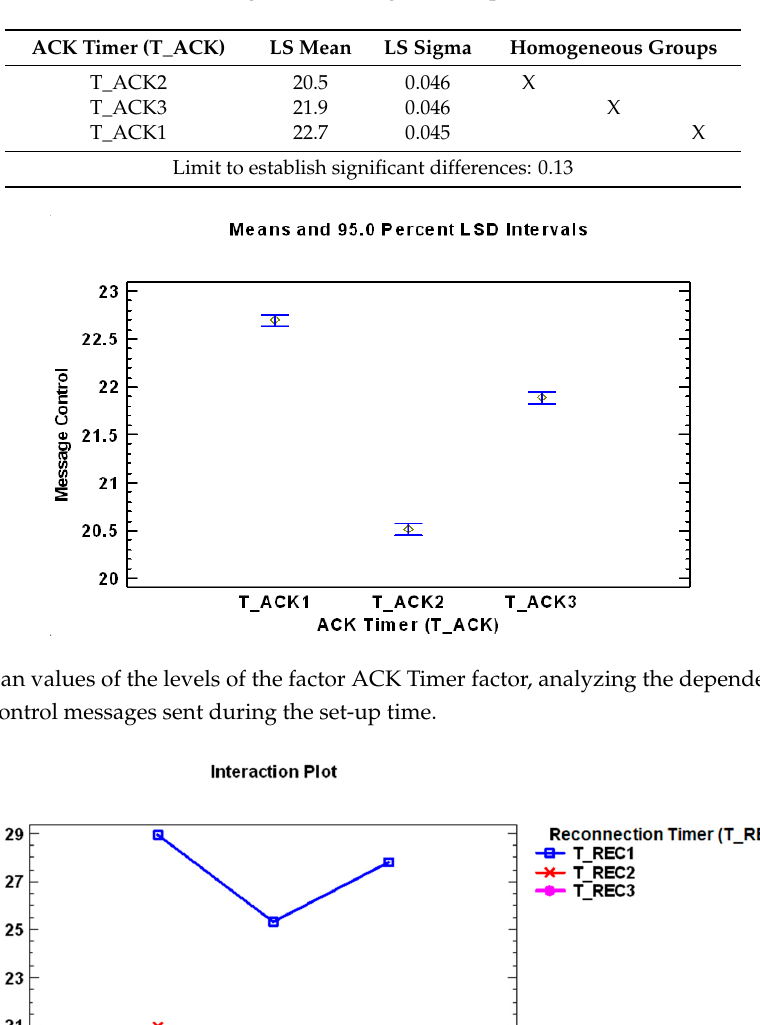
Table 5. Results of the Multiple Range Tests for the factor ACK Timer (T_ACK), using as the dependent variable the Number of control messages sent during the set-up time.